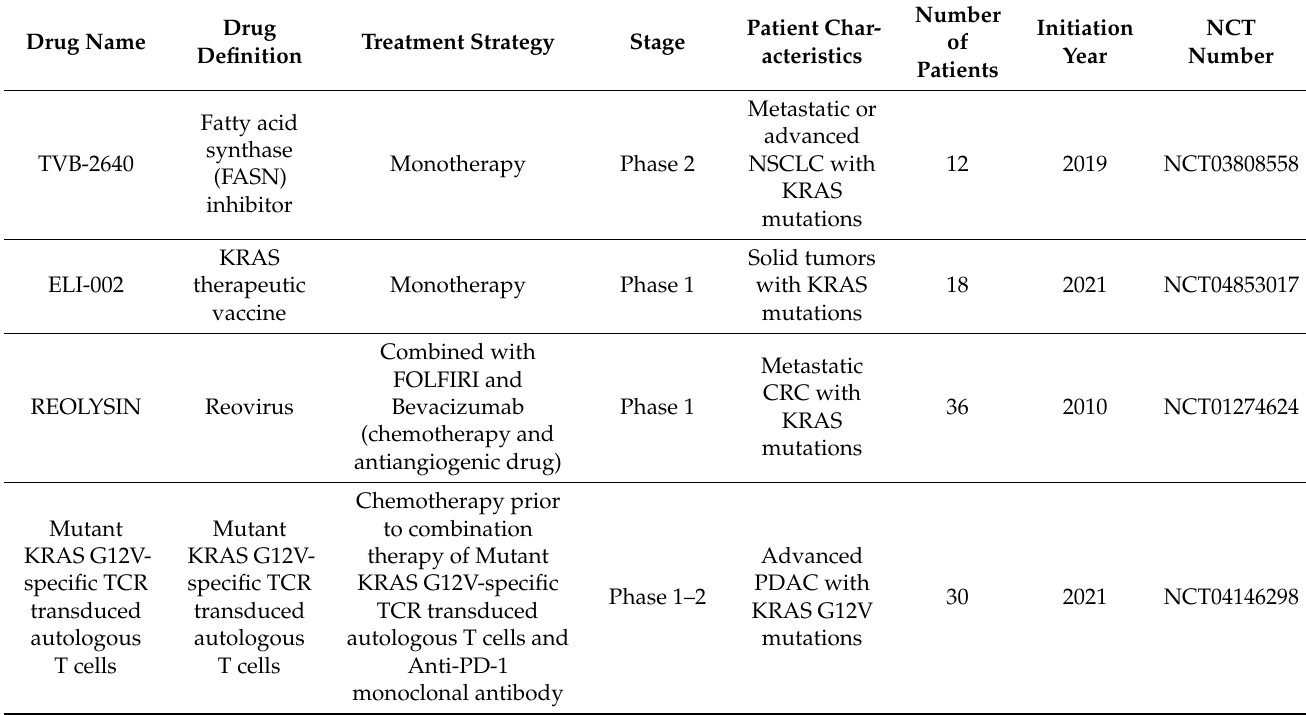
Table 4. Clinical Trials of Other Unconventional Therapies on KRAS Mutant